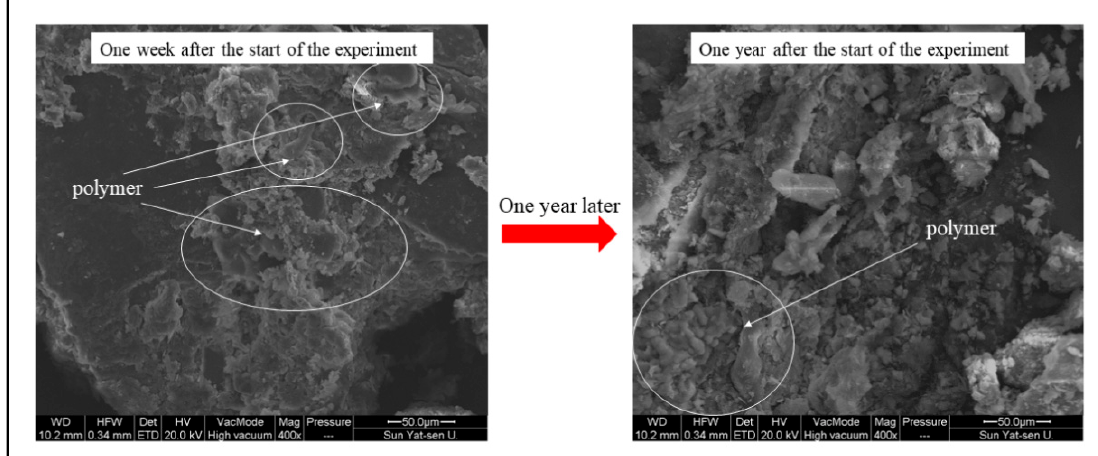
Figure 11. Electron microscope scan image.